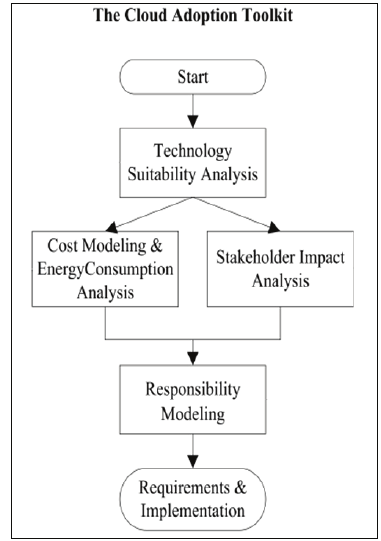
Fig.3. Cloud adoption conceptual framework (source: